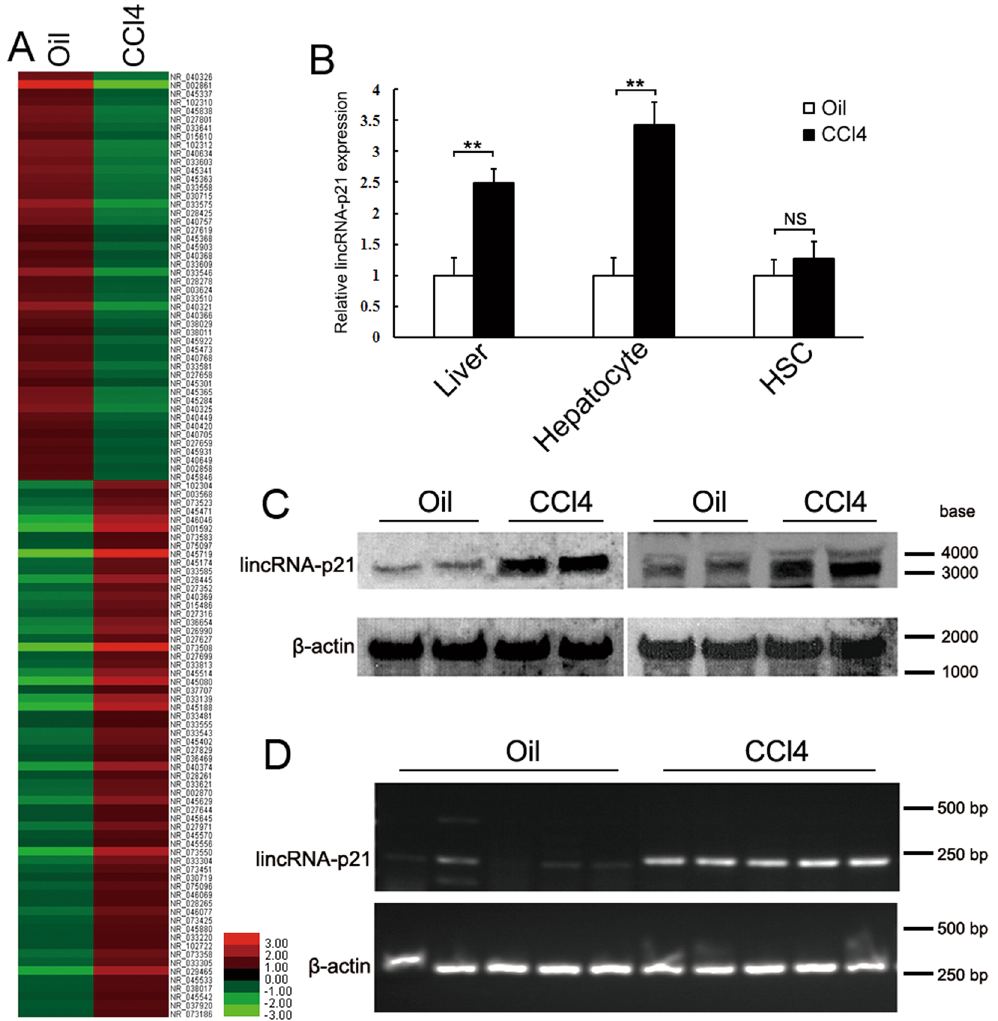
Figure 1. LincRNA-p21 is upregulated in the hepatocyte of CCl 4 -induced fibrotic liver. ( A ) Geometric mean- centered, hierarchical cluster heat map from RNA-seq. 111 annotated lncRNAs (p < 0.05) were represented in the hepatocytes isolated from CCl 4 -induced fibrotic liver (n = 5) compared with hepatocytes from oil-treated liver (n = 5). ( B ) LincRNA-p21 expression was determined in CCl 4 -induced fibrotic liver, hepatocyte and HSC by qRT-PCR. The relative gene expression was normalized against β -actin unless noted otherwise in this study. The results are shown as fold change compared with oil- treated group. ( C and D ) Hepatocyte lincRNA-p21 was detected by northern blot or RT-PCR. RNAs were extracted from isolated hepatocytes of CCl 4 -induced fibrotic liver. Data are the mean ± SEM of three independent experiments. ** P < 0.01. NS, no significant change. The original northern blot and gel images are shown in Supplementary Figure